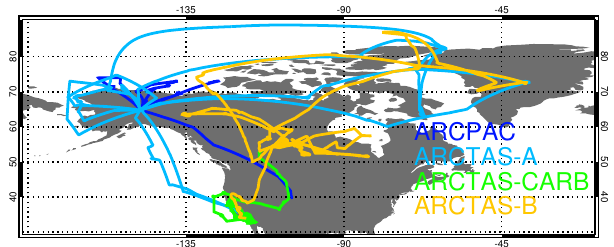
Figure 1. Map of the flight paths of the ARCPAC and ARCTAS aircraft campaigns in 2008 used to evaluate TOMCAT PAN and precursor species. See text for more